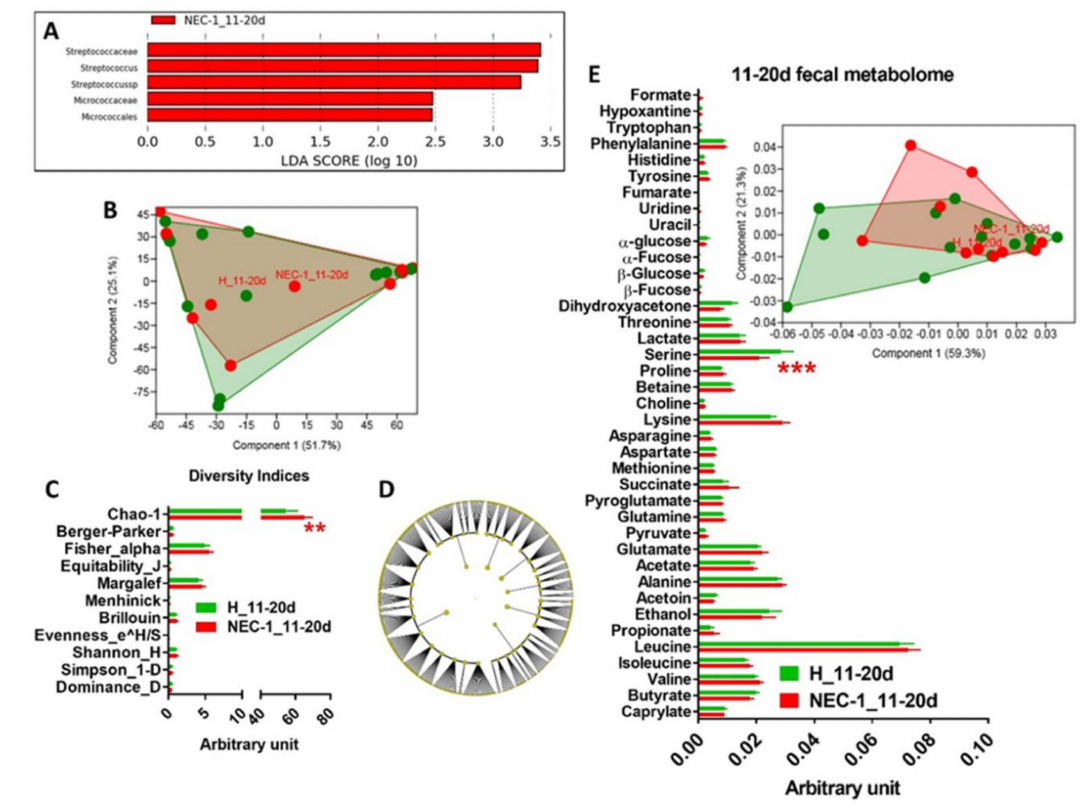
Figure 2. Analysis of gut microbiota, microbiome and metabolome in the second 10-days of life in healthy vs. NEC-1 children. ( A ) Gut microbiota analysis via LDA score between healthy (H) vs. NEC-1 children, in the second 10-days of life, 11 to 20 days (d) (the LDA score is only shown for NEC-1 children meaning that no bacteria are significantly higher in the H group vs. NEC-1); ( B ) PCA of the gut microbiota; ( C ) indices of gut microbiota diversity; ( D ) null cladogram for microbial pathways; ( E ) histogram of the overall fecal metabolites and PCA as inset. ** P < 0.01. *** P < 0.001. Two-way